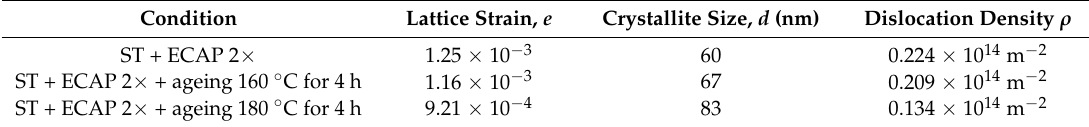
Table 3. Summarised results of the XRD analysis.